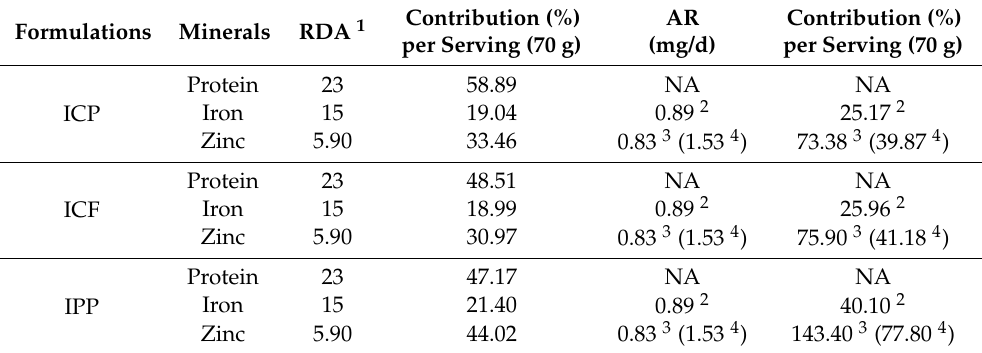
Table 8. Recommended dietary allowances (RDAs) and absolute requirement (AR) of protein, iron and zinc of instant porridge powders and their contribution to RDA and AR. Formulations Minerals RDA